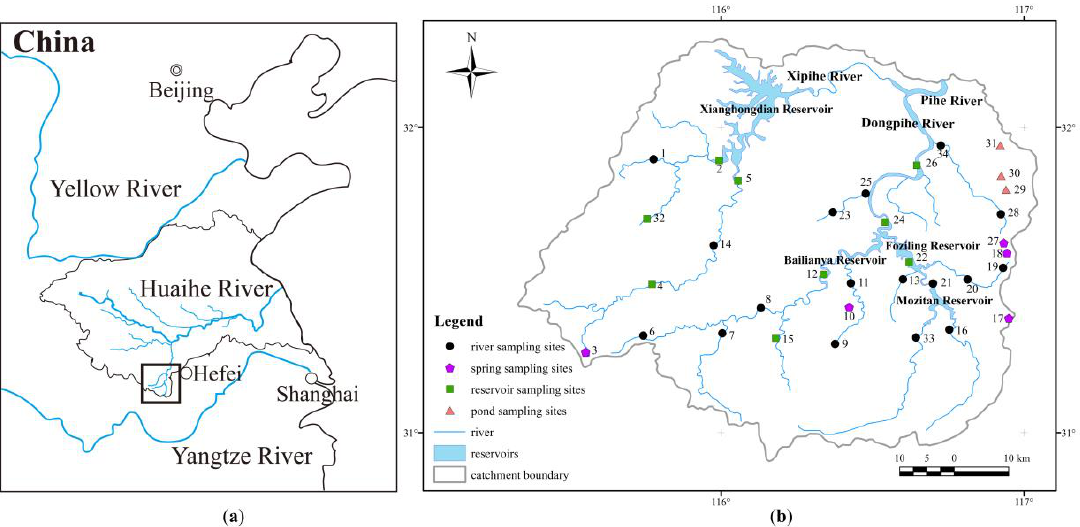
Figure 1. ( a ) Location of the Upper Pi River basin (UPRB) and ( b ) water sampling Figure 1. (a) Location of the Upper Pi River basin (UPRB) and (b) water sampling sites.